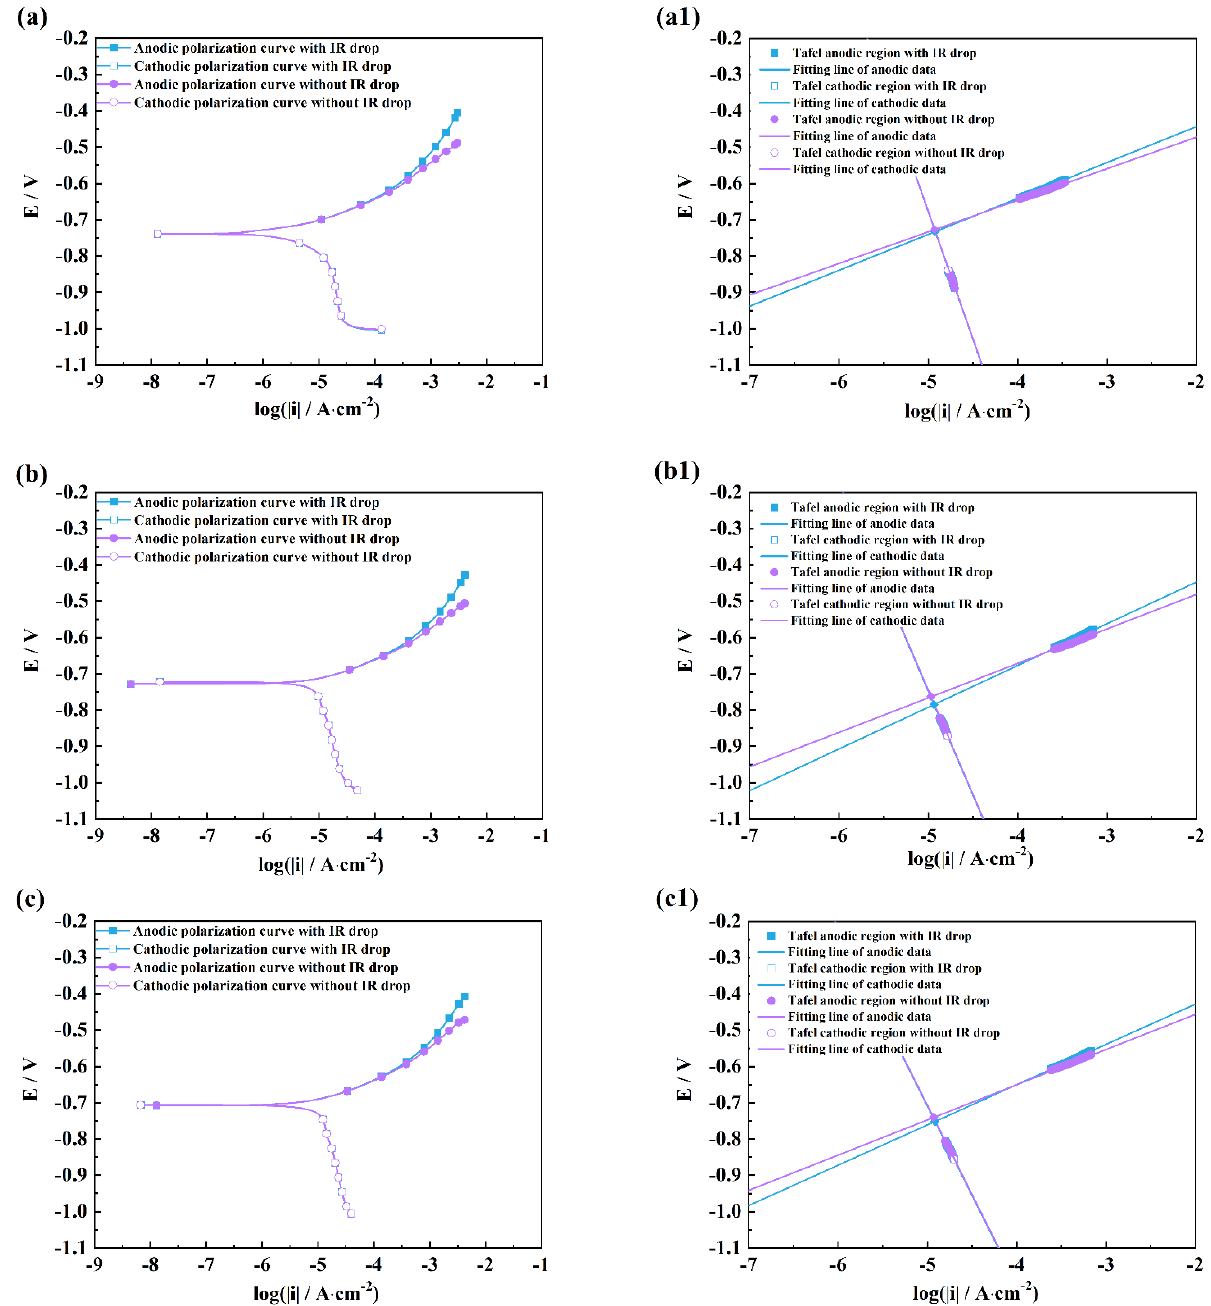
Figure 6. Comparison of polarization curves with and without an IR drop of M1 ( a ), M2 ( b ), M3 ( c ) and linear fitting plots of the Tafel regions of M1 ( a1 ), M2 ( b1 ), M3 ( c1 ) in NaCl solutions after 2 h exposure.